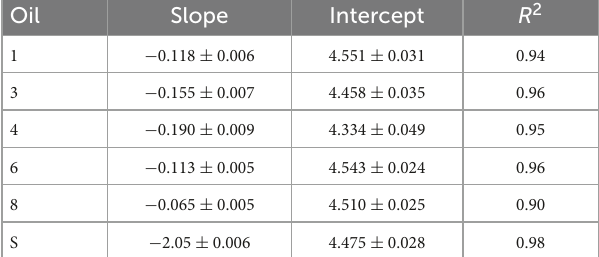
TABLE 3 Models for dose response of bacterial production inhibition.